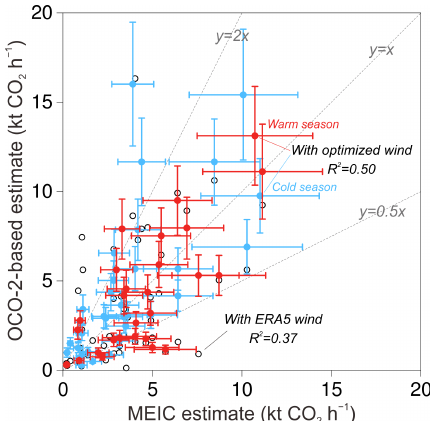
Figure 3. Comparison between OCO-2-based and MEIC-estimated CO 2 hourly fluxes. Each dot represents one of the 60 plume cases selected in this study, plotted according to the MEIC-estimated CO 2 flux ( x axis) and the OCO-2-based estimate ( y axis). The open dots are OCO-2 estimates using the ERA5 wind data, while the solid dots use the optimized wind and distinguish the warm-season (red dots) and the cold-season (blue dots)